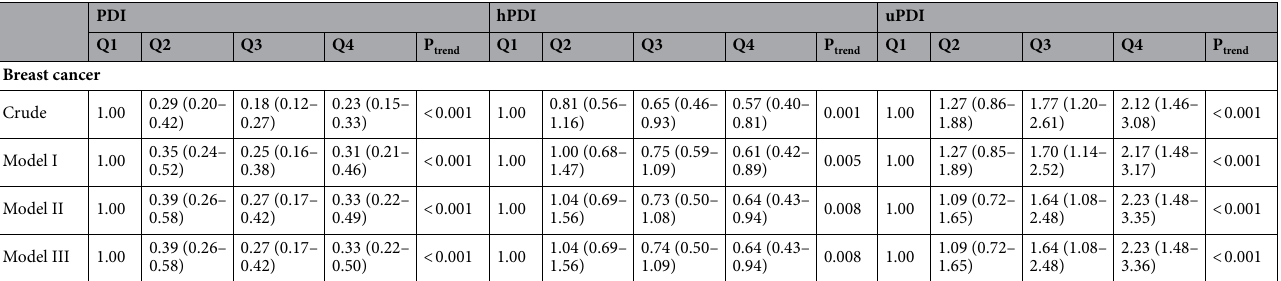
Table 4. Crude and multivariable-adjusted ORs and 95% CIs for breast cancer across quartiles of PDI, hPDI, and uPDI scores. Data are presented as OR (95% CI). Model I: Adjusted for age and energy intake. Model II: Additionally, adjusted for education, social economic status, residential area, supplement use, family history of breast cancer, disease history, physical activity, marital status, smoking status, alcohol consumption, history of breast-feeding and menopausal status. Model III: Further adjustment for